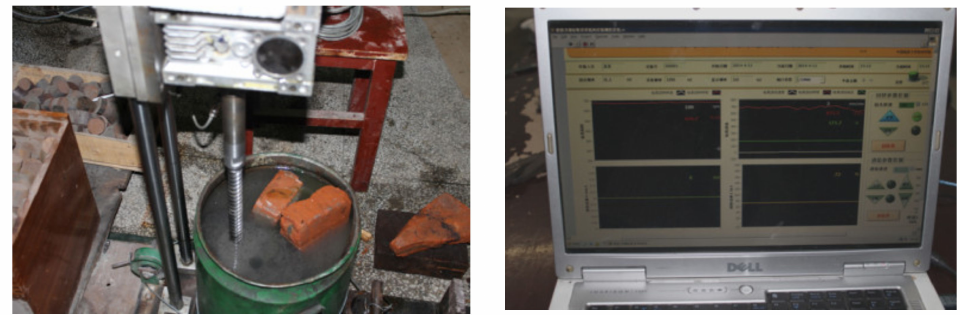
Figure 10. The setup of the drilling